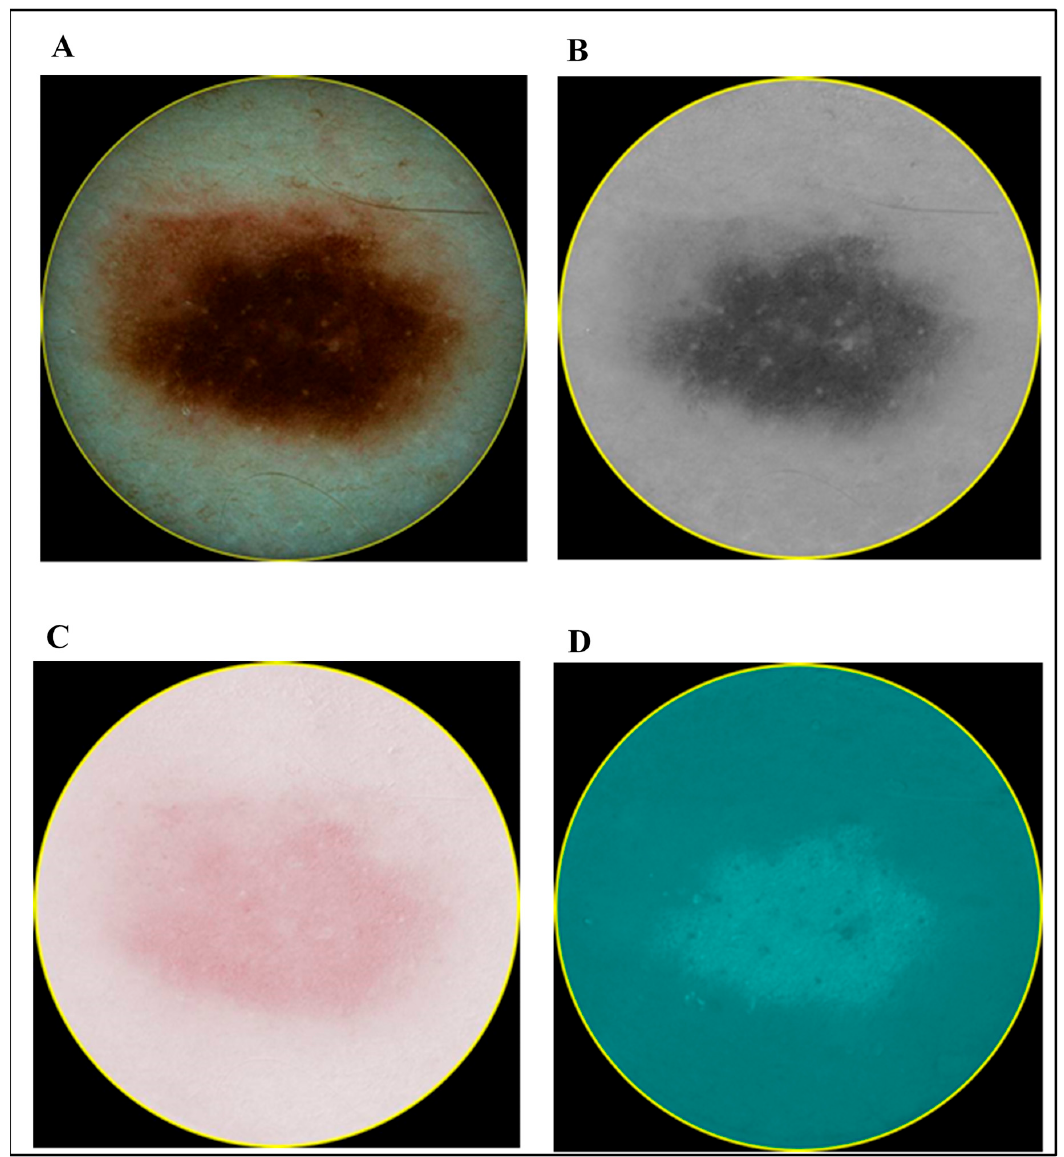
Figure 4. Images of melanocytic naevus (MN): dermatoscopy ( A ) and different components acquired by spectrophotometry (melanin ( B ), blood ( C ) and collagen ( D )). The same number (thirteen) of the quantitative parameters as computed in the case of ultrasonic B-scan images were computed from these images as well. However, not all of these parametric values were statistically significant to be used further for classification. Only those parameters that were statistically significant ( p < 0.05 by using t -test) in each case (optical dermatoscopic images, spectrophotometric images and ultrasonic B-scan images), were selected to be used as input data for the binary classification algorithm. The selected sets of parameters are presented in Table 1. Table 1. Numbers of selected quantitative parameters to be used for binary classification of images acquired using different imaging technologies (1—entropy, 2—energy, 3—contrast, 4—correlation,